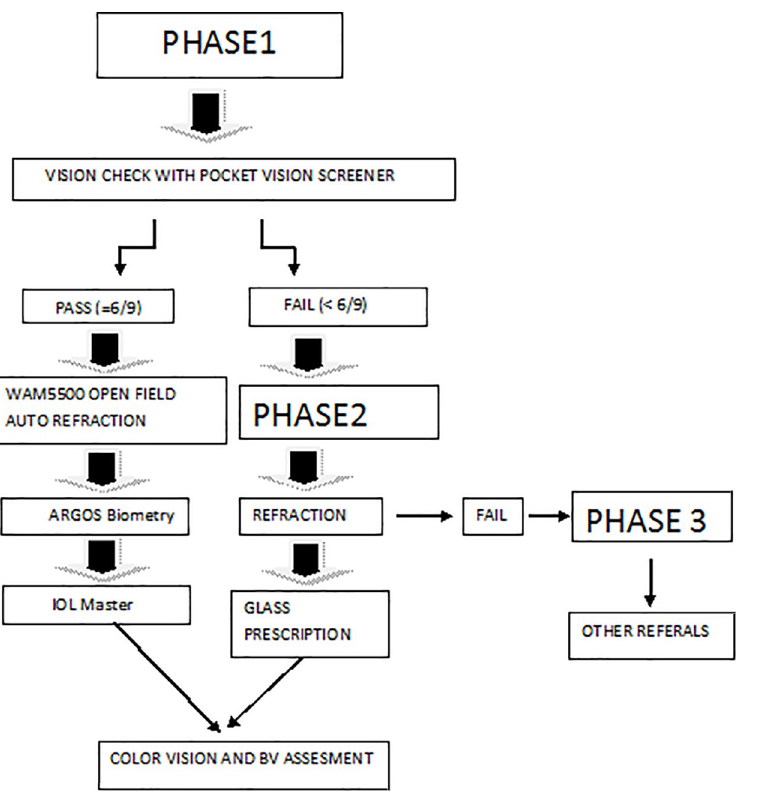
Fig 1. Flow chart of the school vision screening